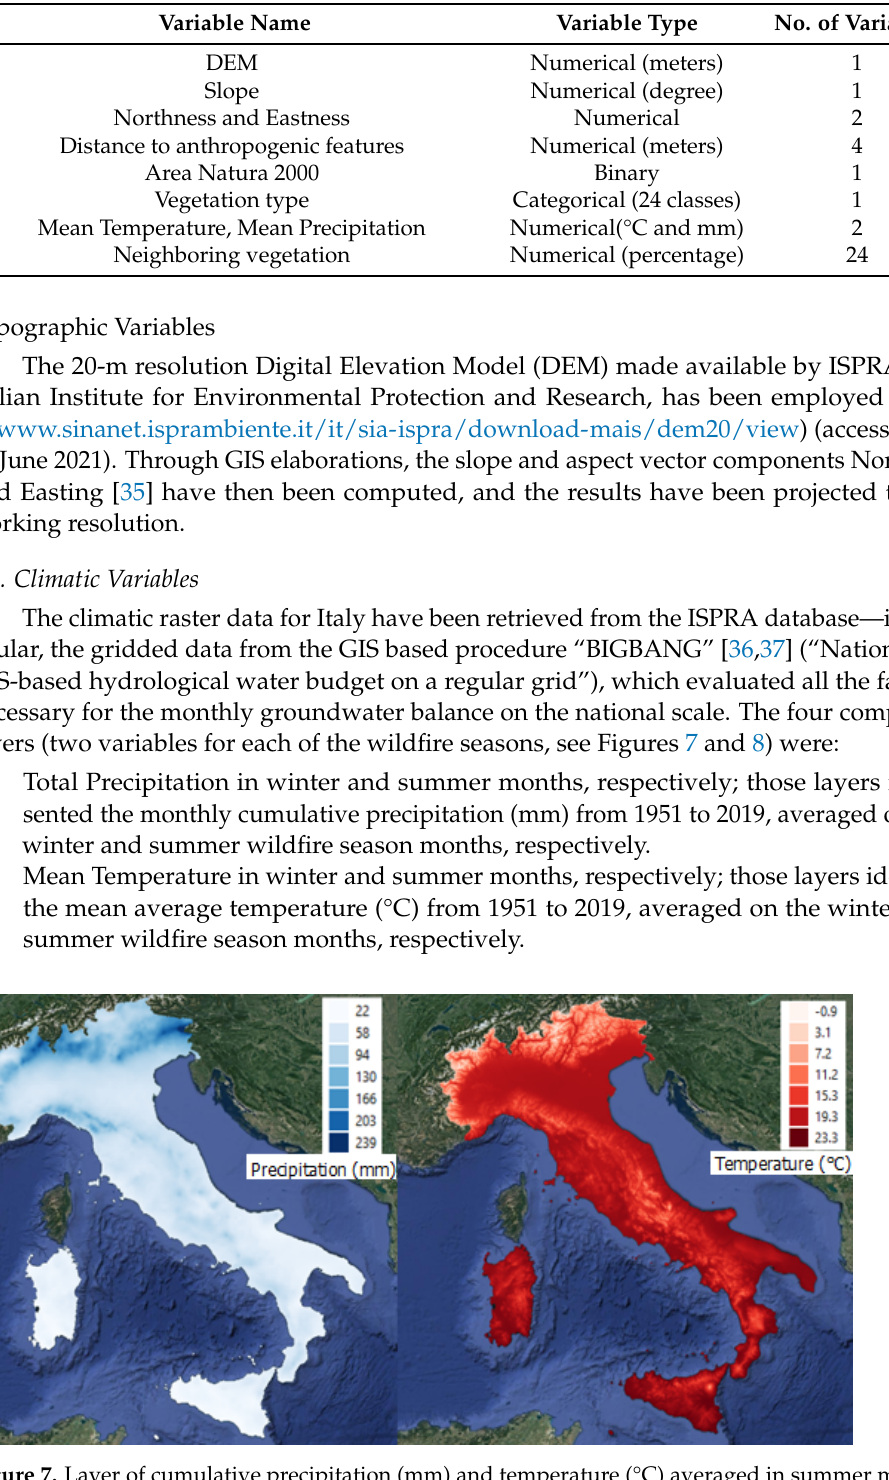
Figure 7. Layer of cumulative precipitation (mm) and temperature (°C) averaged in summer